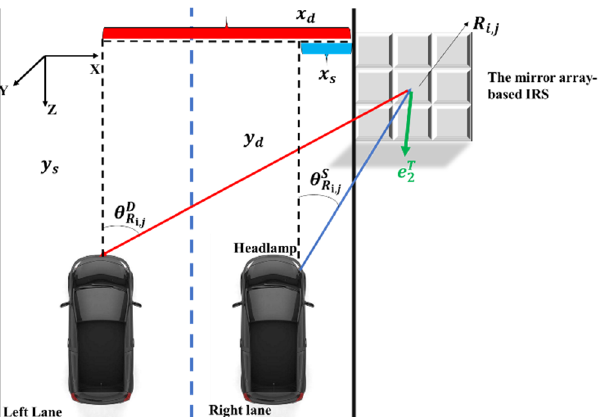
Figure 1. Application scenario of the VLC system via mirror array-based IRS for parallel vehicles. The model diagram of this scenario is given in Figure 2 for the convenience of analysis.